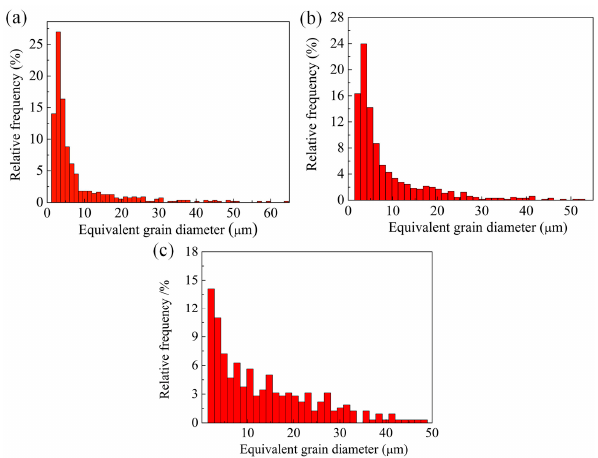
Figure 4. Histograms of equivalent grain diameter for the NiTiFe SMA subjected to ECAE at various temperatures: ( a ) 400 °C; ( b ) 450 °C; ( c ) 500 °C.